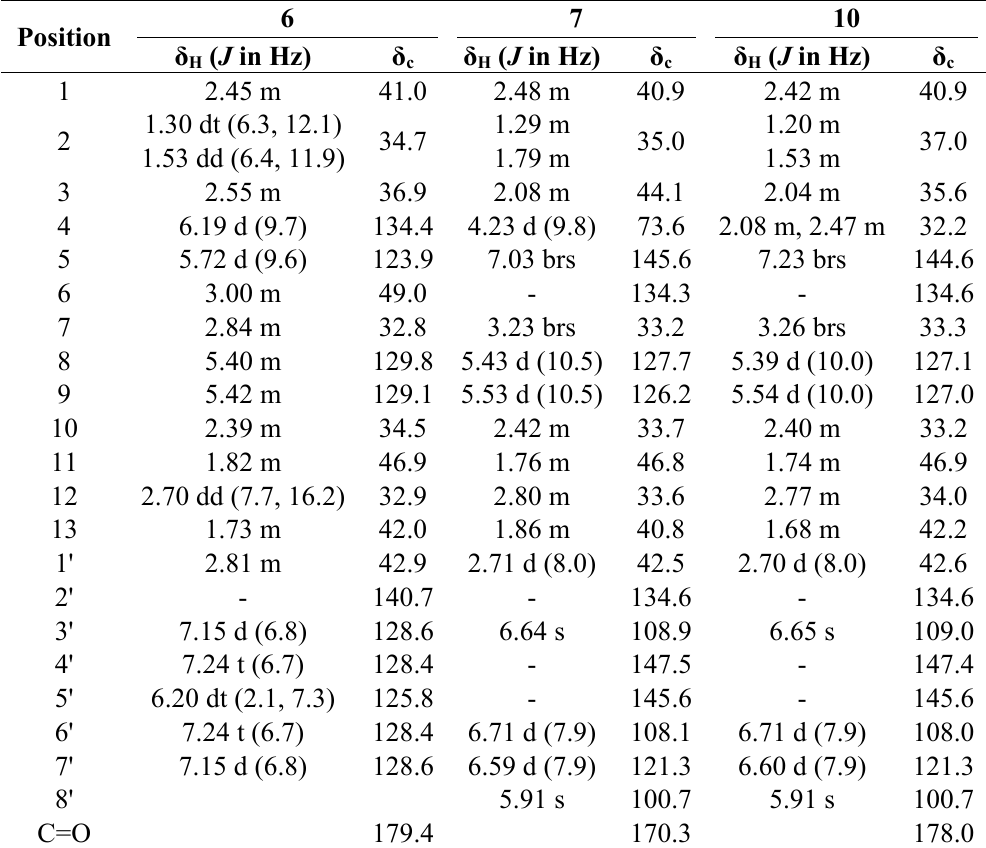
Table 3. 1 H (600 MHz) and 13 C (150 MHz) NMR data of compounds 6 , 7 , and 10 (CDCl